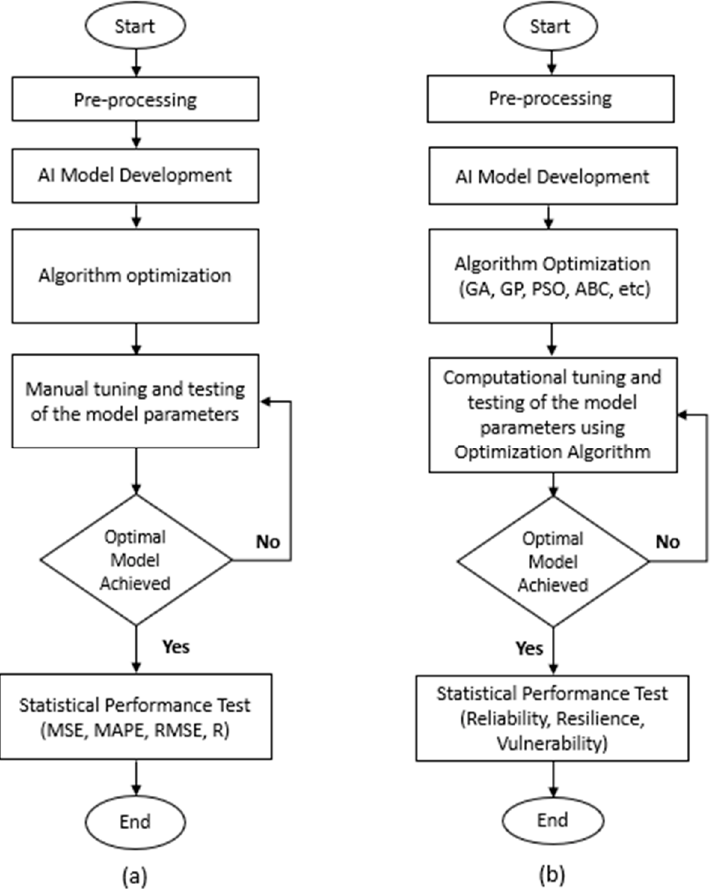
Figure 10. Comparison between ( a ) stand-alone model and ( b ) optimized models, as adapted from Ref. [40].